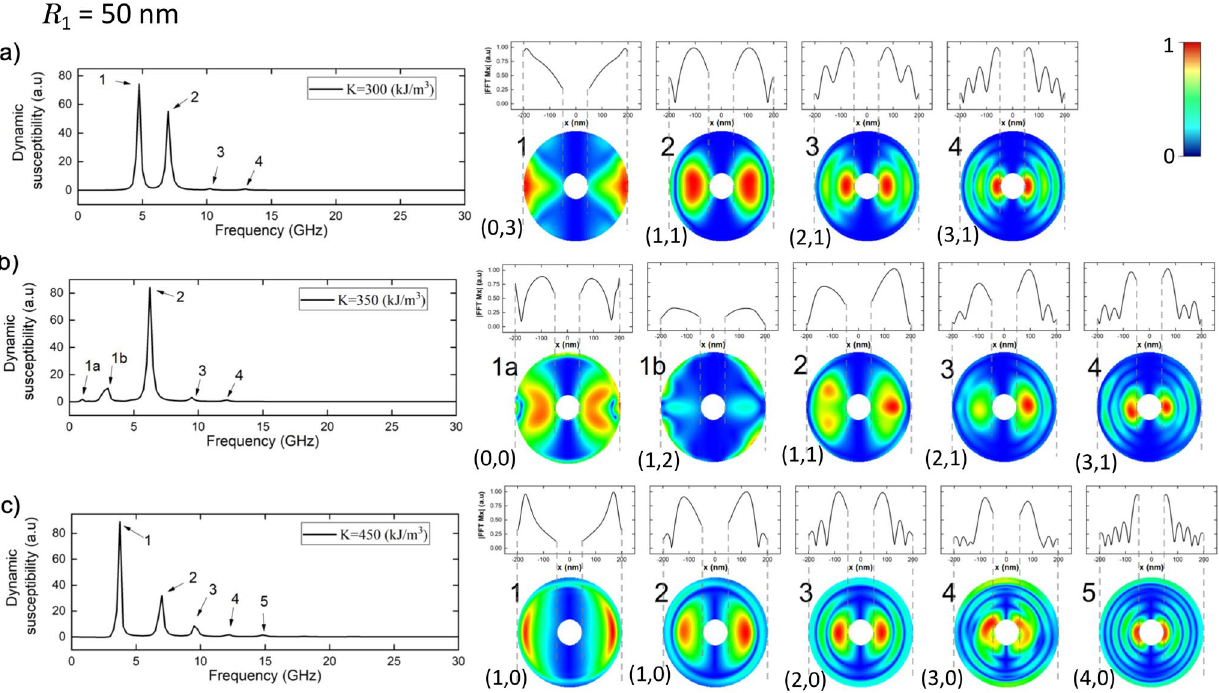
Figure 5. Resonance modes for the widest ring for a RPMA strength of ( a ) 300, ( b ) 350 and ( c ) 450 kJ / m 3 . At the left it is shown the imaginary part of the susceptibility as a function of the frequency of sample. The spatial distribution of the amplitude of resonance in the ring for each mode is depicted at the right by snapshots, while the plot above each snapshot show FFT power profile along the pulse direction in the equatorial line ( x -direction at y = 0 ). Besides, each mode is characterized in terms of number of radial and azimuthal nodes (n,m),